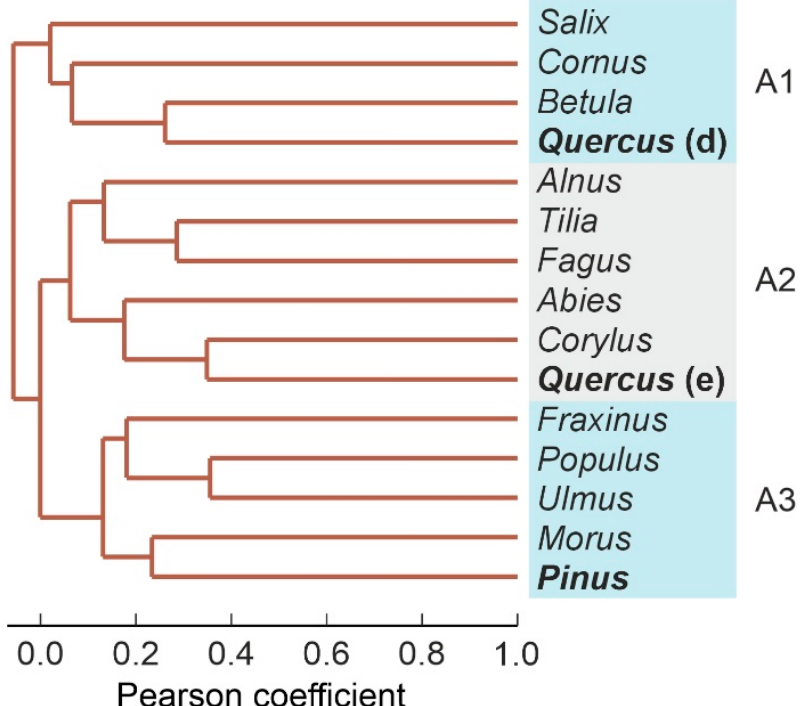
Figure 12. Cluster analysis of forest-tree pollen elements performed using the Pearson coefficient and the UPGMA clustering approach [57,58]. The dominant taxa of each forest assemblage are in bold. A1, assemblage 1; A2, assemblage 2; A3, assemblage 3.